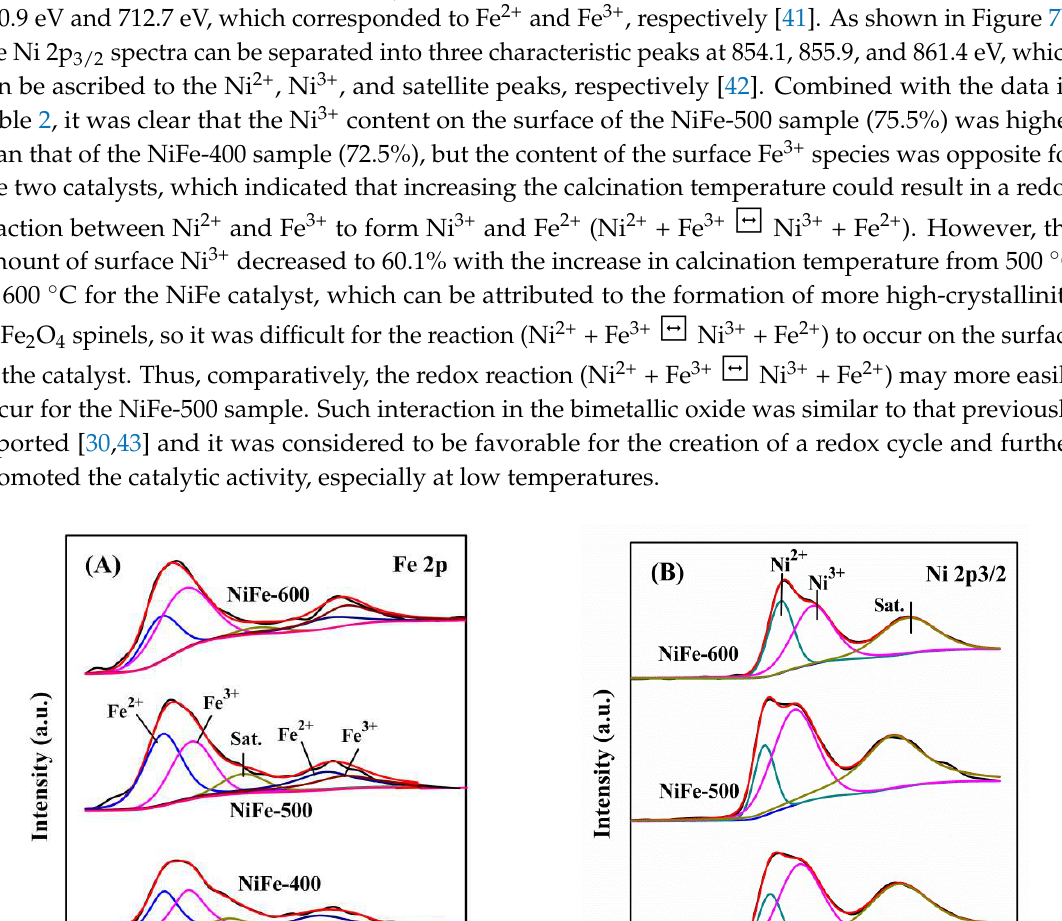
Figure 6. The ideal model of catalysts with MO x (M = Ni or Fe) or multiple phases (MO x and a NiFe 2 O 4 spinel).